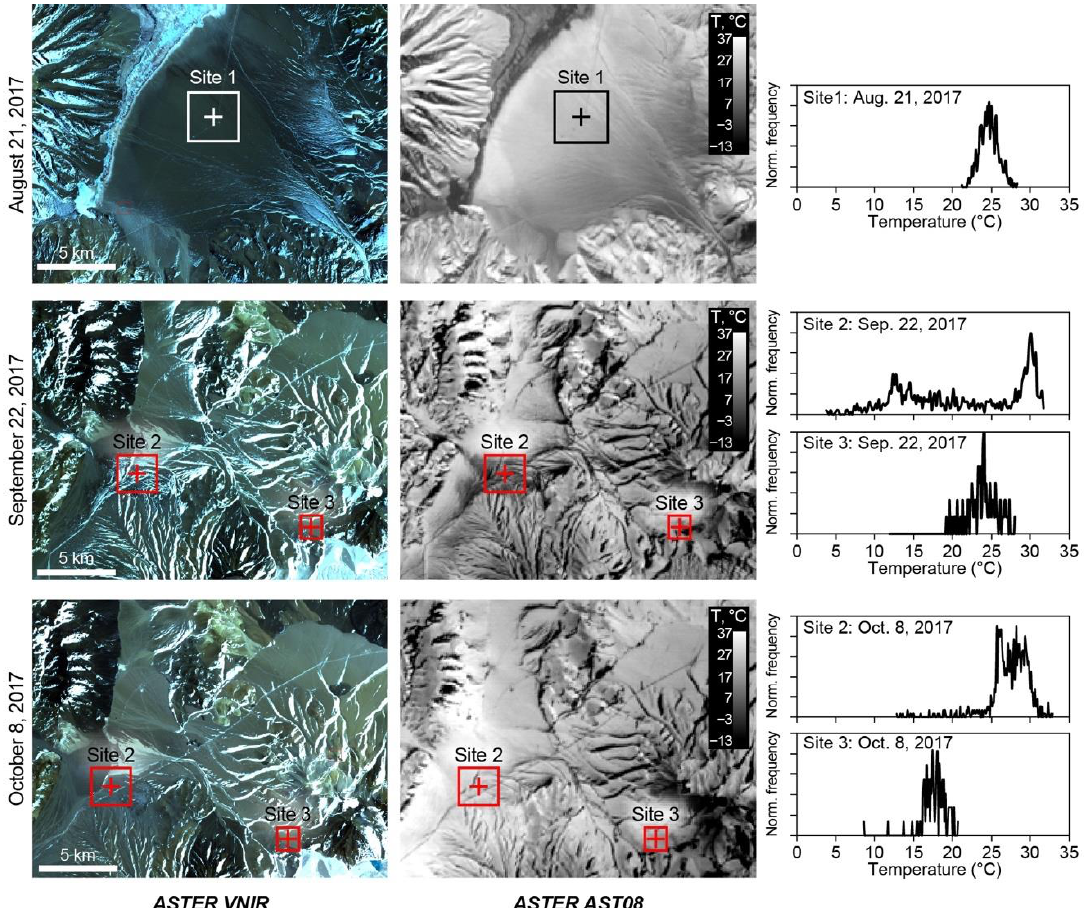
Figure 10. ASTER image pairs (VNIR and Surface Kinetic Temperature, AST08) for three dates in 2017. On 21 August, a 1-km 2 MODIS pixel indicated Site #1 to be snow-covered, which the 15-m pixel − 1 ASTER VNIR image disagrees with. On 22 September, MODIS indicated both sites #2 and #3 to be snow-free; ASTER shows them to be largely bare. On 8 October, MODIS indicates both sites #2 and #3 to be snow-free, which ASTER confirms. The MODIS snow classifications are binary (snow or no-snow). Modal temperatures (11:43 AM local AST08) for snow-free pixels are 23–30 ◦ C and 12 ◦ C for largely snow-covered pixels (22 September, SE corner Site #2). Even the lowest temperatures for snow cover or partial cover were above zero, implying significant temperature mixing with sun-heated rocks rising above the snow.